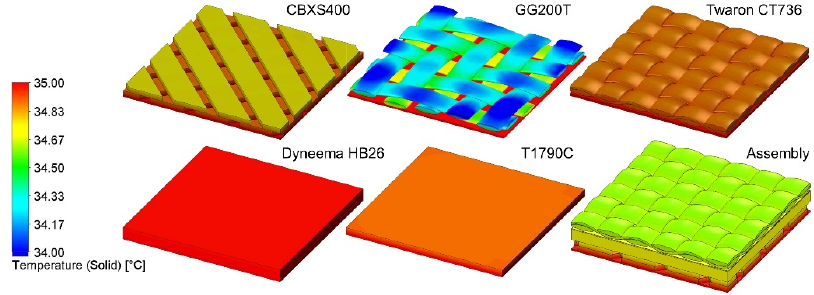
Figure 9. Temperature distributions on 3D models of five tested textiles and assembly.